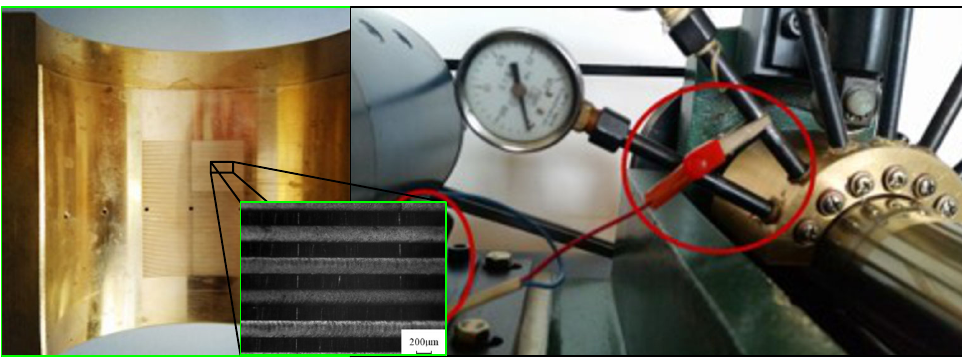
Figure 19. Bearing bush and test bench with streamwise